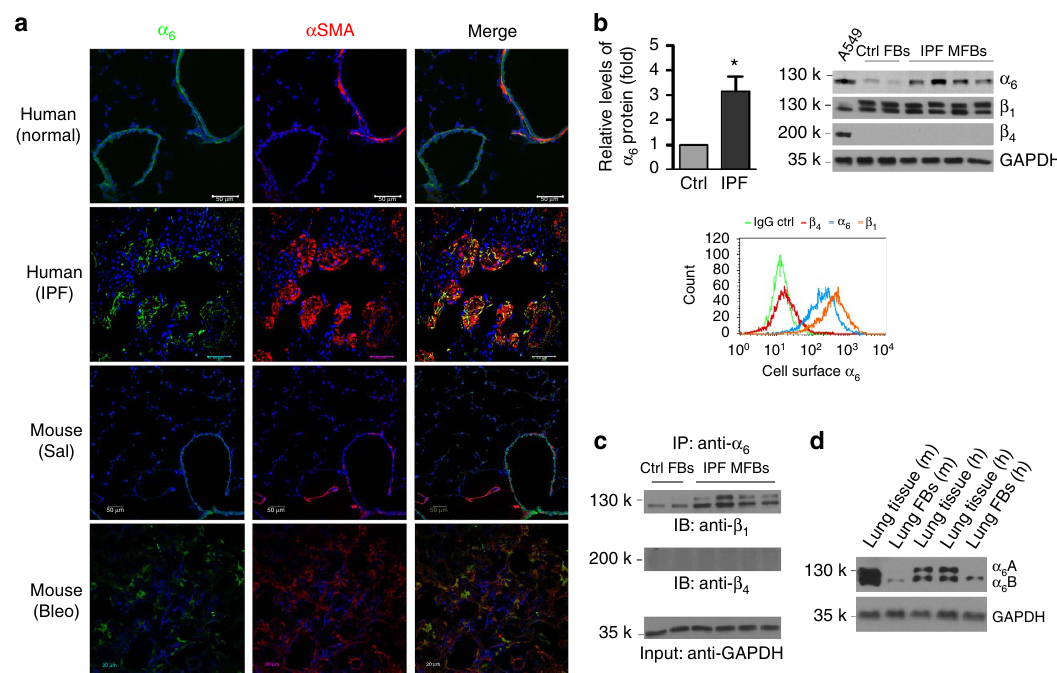
Figure 3 | Lung myofibroblasts demonstrate increased a 6-expression. ( a ) Frozen lung tissue sections obtained from failed normal human donors, patients with IPF, saline-treated mice and bleomycin-treated mice were double-stained for a 6 (green) and a SMA (red). Nuclei were stained by DAPI (blue). Confocal immunofluorescent images were overlaid to show a 6 -expression in a SMA-positive lung myofibroblasts. Scale bar, 50 m m; scale bar, 20 m m for mouse with bleo images. ( b ) Comparison for a 6 -expression in lung (myo)fibroblasts isolated from patients with IPF ( n ¼ 10) and non-ILD control human subjects ( n ¼ 6) by immunoblot; Relative levels of a 6 -protein normalized to GAPDH expression. Results are the means ± s.d. Representative blots for a 6 -expression as well as b 1 - and b 4 -expression were shown. A549 cells were used as positive control for b 4 -expression in immunoblot analysis. Relative levels of a 6 -, b 1 - and b 4 -expression on the cell surface of IPF lung myofibroblasts were analysed by flow cytometry. ( c ) Detection of a 6 b 1 - and a 6 b 4 -complexes in IPF lung myofibroblasts by immunoprecipitation and immunoblot. ( d ) Identification of a 6 A and a 6 B expression in human and mouse lung tissues and fibroblasts by immunoblot; * P o 0.05, one-way analysis of